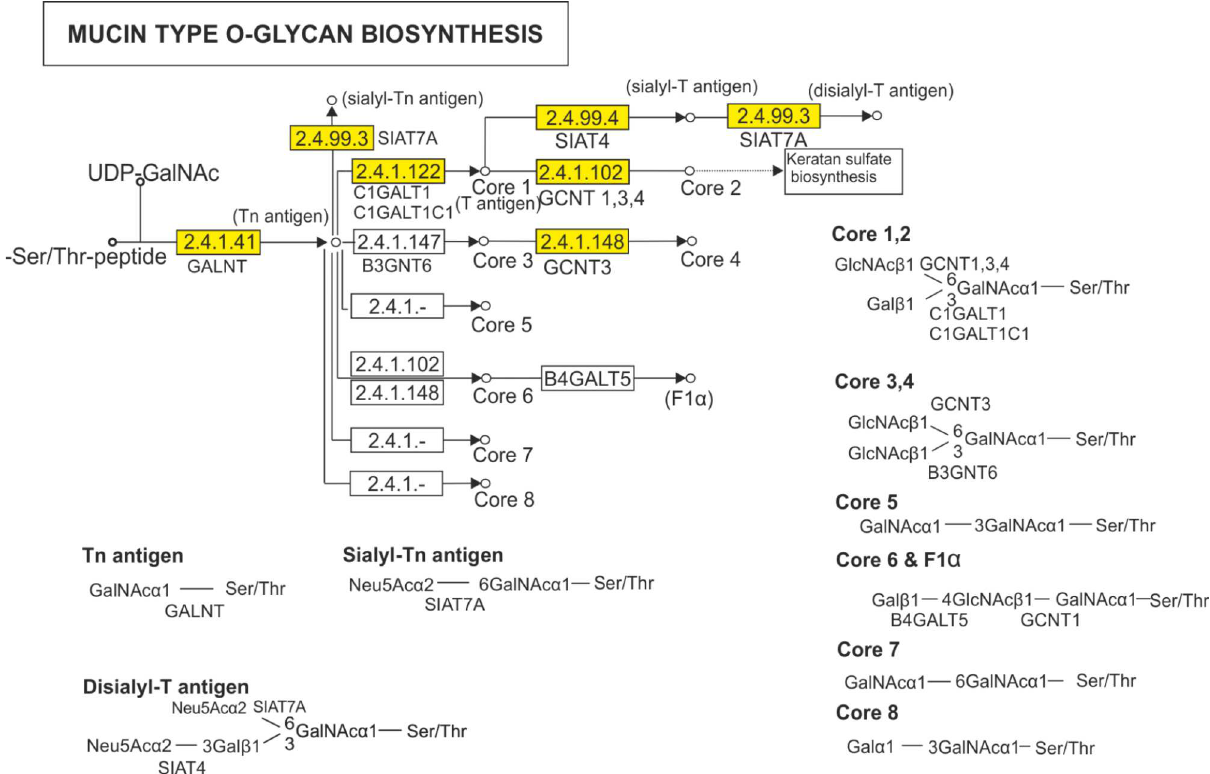
Fig 5. Map of the mucin type O-glycan biosynthesis pathway. Genes identifiedfrom the sea trout skin transcriptome are shown in yellow.